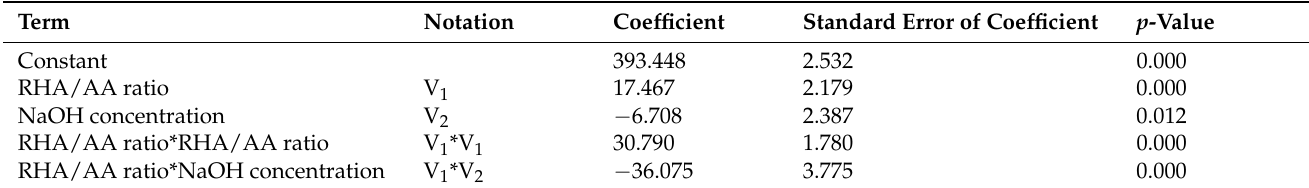
Table 7. Estimated effects and coefficient for RHA/AA ratio and NaOH concentration on the